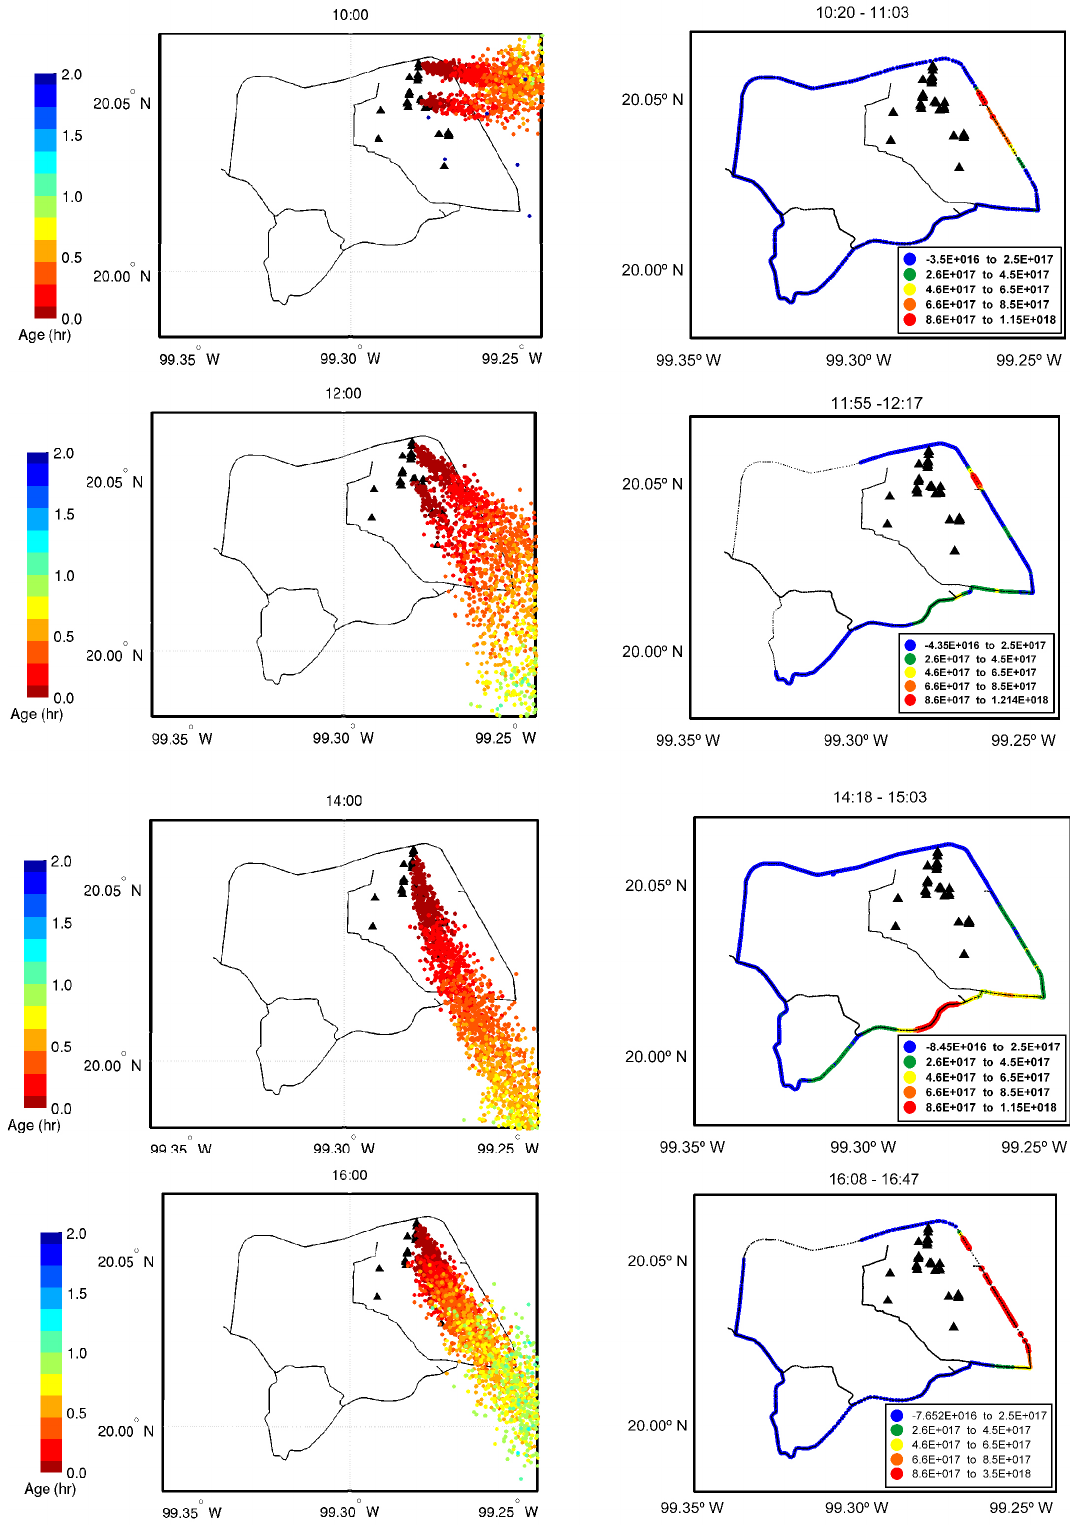
Fig. 5. Comparison between modeled plumes (left) and observed spatial distribution of SO 2 columns (right) during 26 March 2006. Known sources of the power plant and refinery are shown with black triangles. The units of the differential vertical SO 2 columns are molecules/cm 2